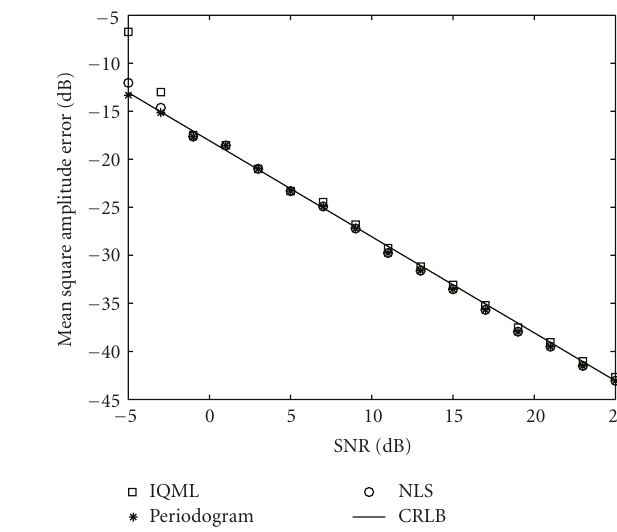
Figure 24: MSE for A of 2D single complex sinusoid.